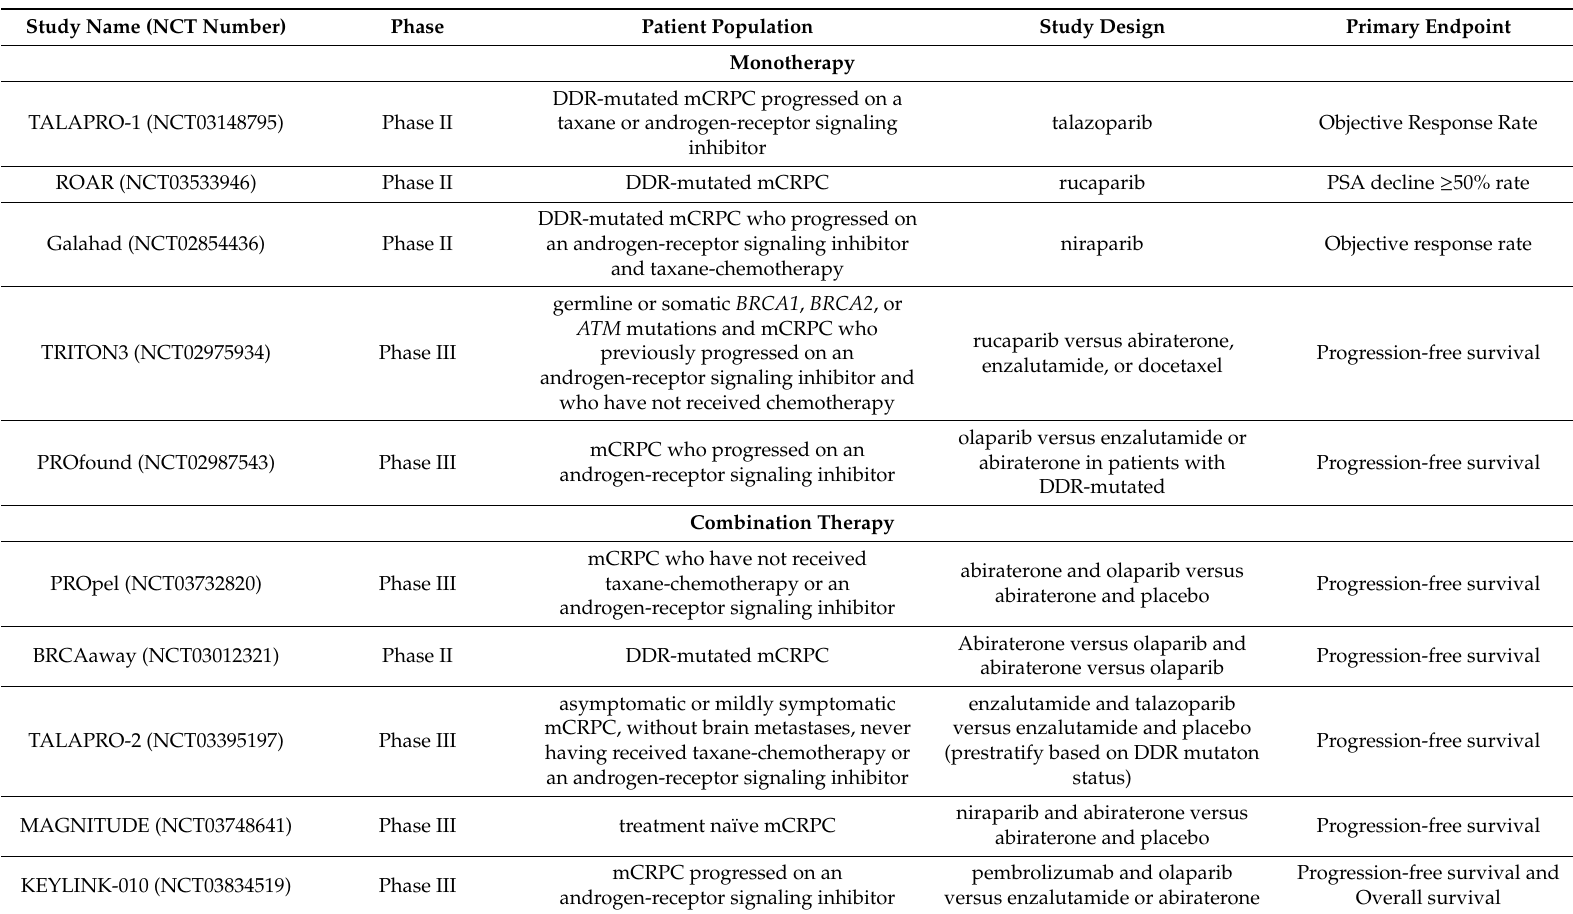
Table 3. Ongoing PARPi trials in prostate